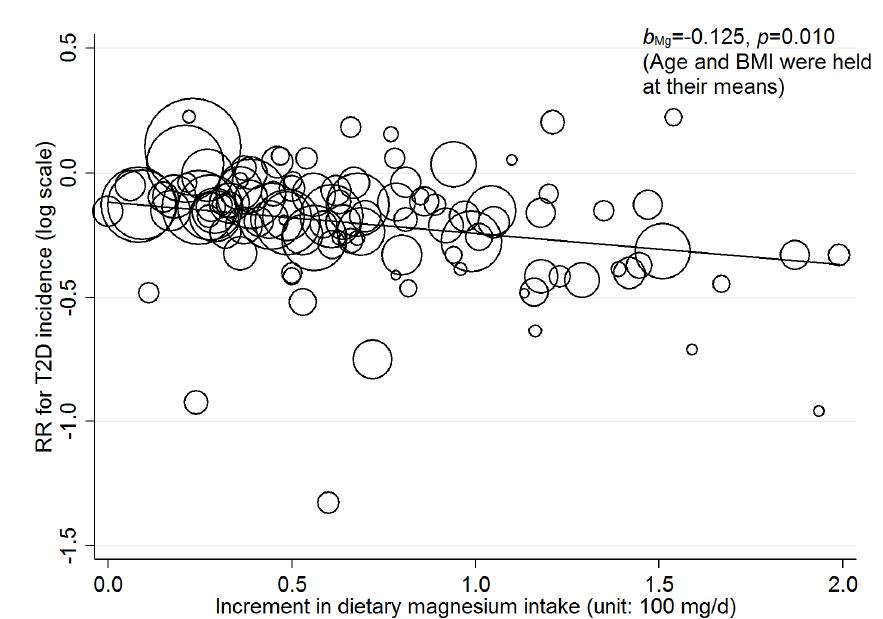
Figure 4. Dose-response relationship between risk of T2D incidence and incremental dietary magnesium intake (excluding one extreme dose). The size of the bubble reflects the study-specific analytical weight, i.e., the inverse of the variance.